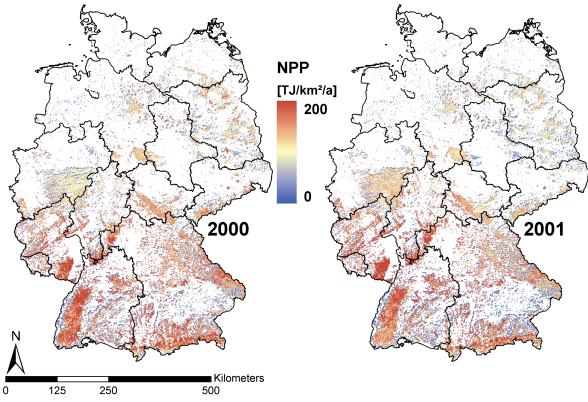
Fig. 7. Sustainable theoretically available energy potential, in ter- ajoules per 1km 2 pixel, of forest areas in Germany for 2000 and 2001. Low energy potentials are shown in blue, intermediate poten- tials in beige, and high energy potentials in red. White represents, as in Fig. 3, areas which are not designated as forested by GLC2000 (see Table